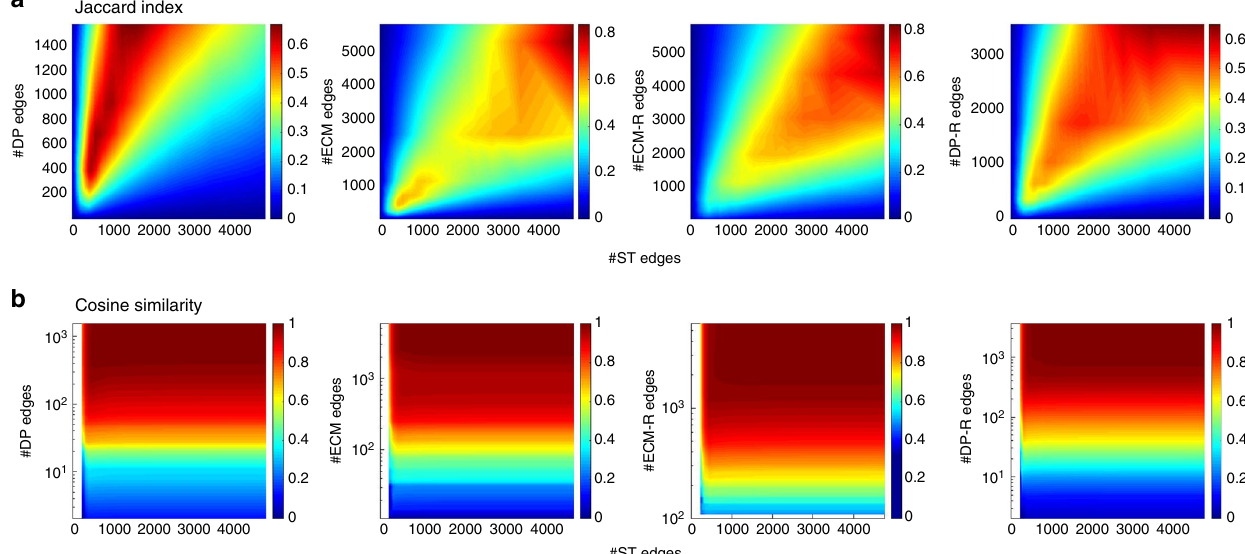
Fig. 4 Comparison between the sets of edges detected as signi fi cant by different fi lters, for the Highschool data. a The Jaccard index is de fi ned by J ð I α ; I α ′ I α ∪ I α ′ x ∈ {DP, ECM, ECM − R, DP − R}. We plot the Jaccard index versus the numbers of edges detected at different \ I α ′ x j = j I α x Þ ¼ j x j , where ST ST ST signi fi cance levels, ranging from α = 10 − 17 to 0.5 (obviously, the higher the value of α , the larger the number of signi fi cant edges). b Same for the cosine similarity de fi ned in Eq.